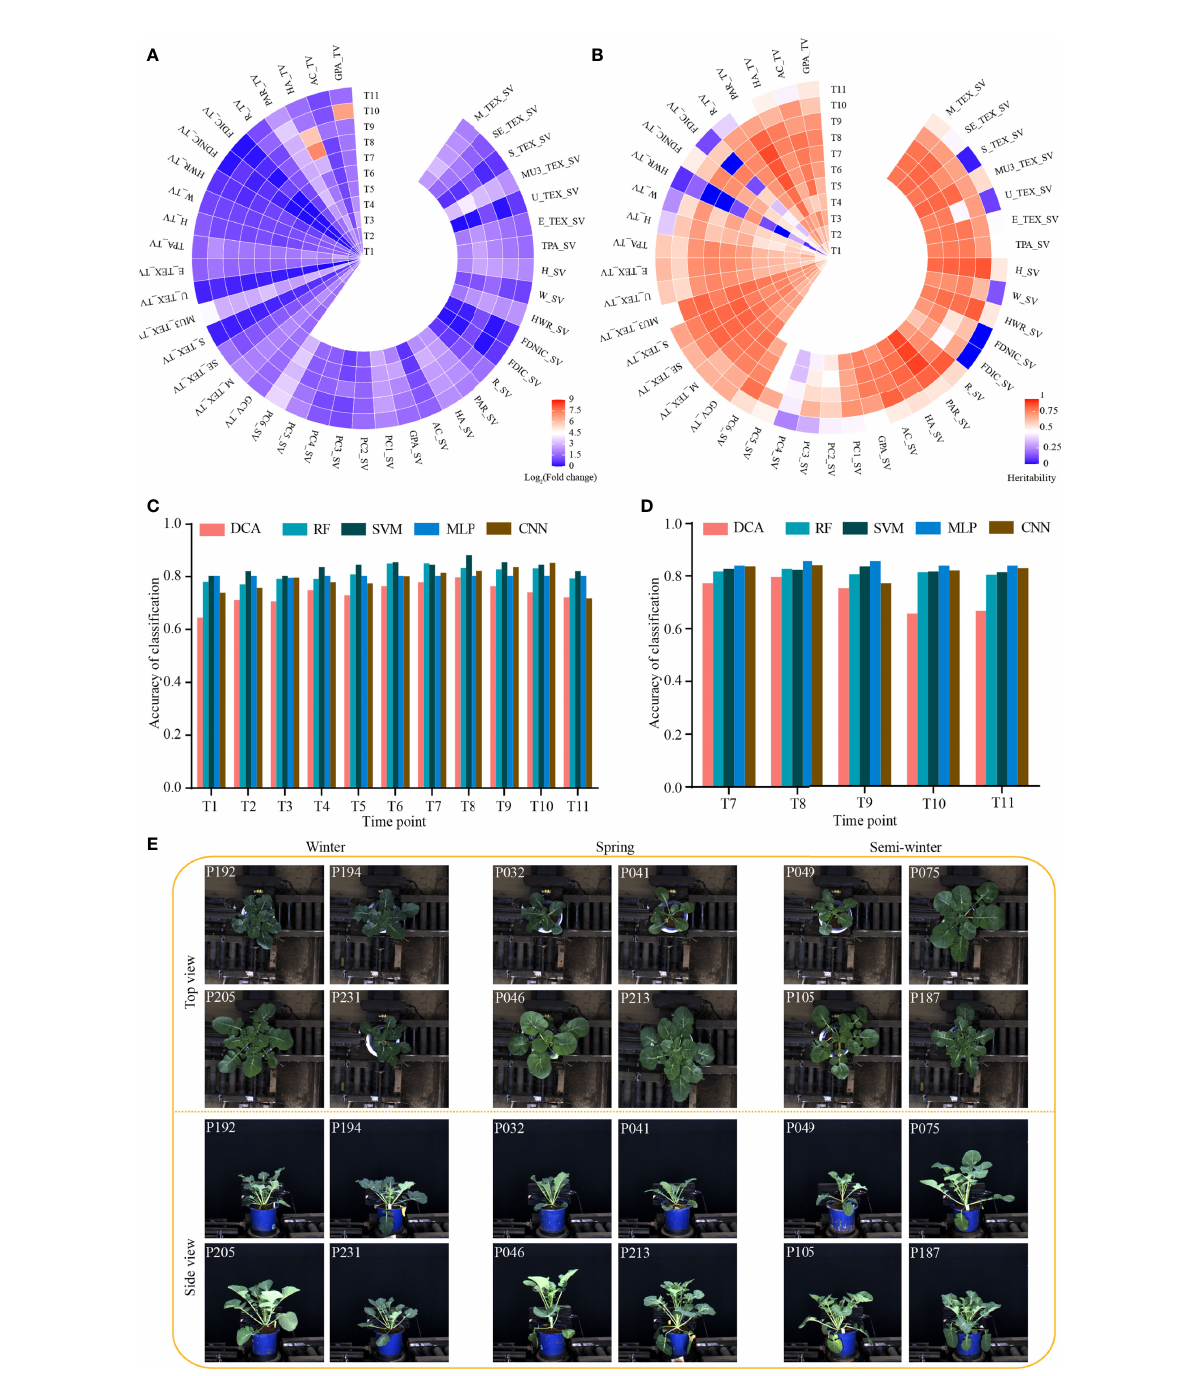
FIGURE 1 Dynamic phenotype of 43 i-traits across 11 time points and performance of models distinguishing the rapeseed ecotype. (A) Heat map showing the phenotypic fold change. (B) Heat map showing the broad-sense heritability ( H 2 ) of traits. (C , D) Classi fi cation accuracy of fi ve machine learning models based on the i-traits in top-view from T1-T11 (C) and side view from T7-T11 (D) . DCA, discriminant analysis; RF, random forest; SVM, support vector machine; MLP, multilayer perceptron; CNN, convolutional neural network. (E) Images of three rapeseed ecotypes from T7 in top view and side view. The top-left numbers indicated the No. of displayed